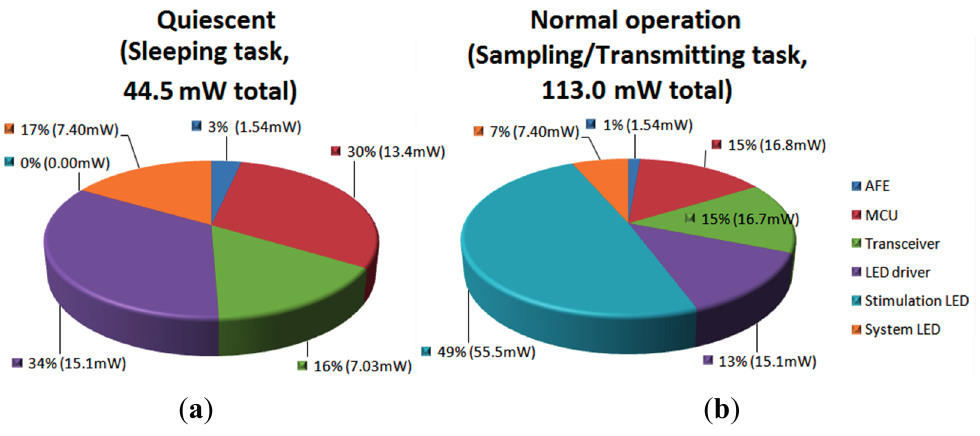
Figure 8. Power consumption of the headstage (V DD = 3.7). ( a ) sleeping task; ( b ) sampling/transmitting task (with optical stimulation